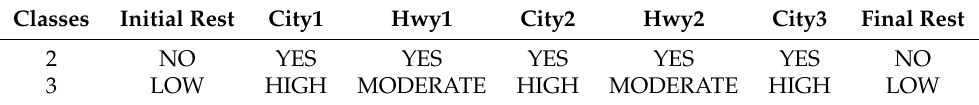
Table 2. DriveDB driver events and corresponding annotations for 2 and 3 classes of